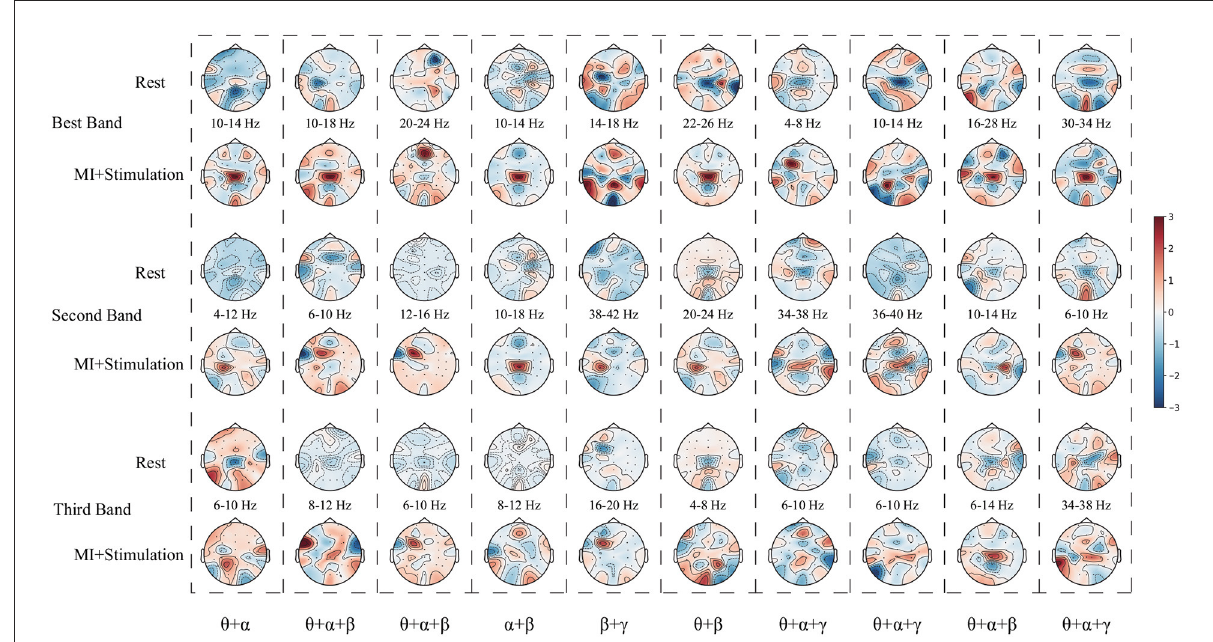
FIGURE10 The topographic map learned by the three selected sub-bands corresponding to the top three group coefficients from subjects A01–A10 of the in-house dataset with stimulation.